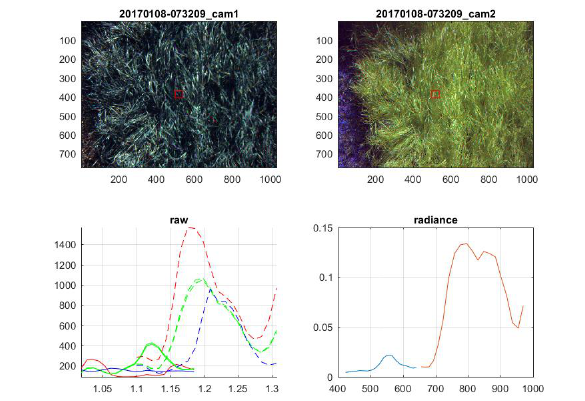
Figure 13 False color images of the DroneKnowledge VIS (cam1) and VNIR (cam2) hyperspectral cameras, raw signal and radiance signal at the selected subwindow.